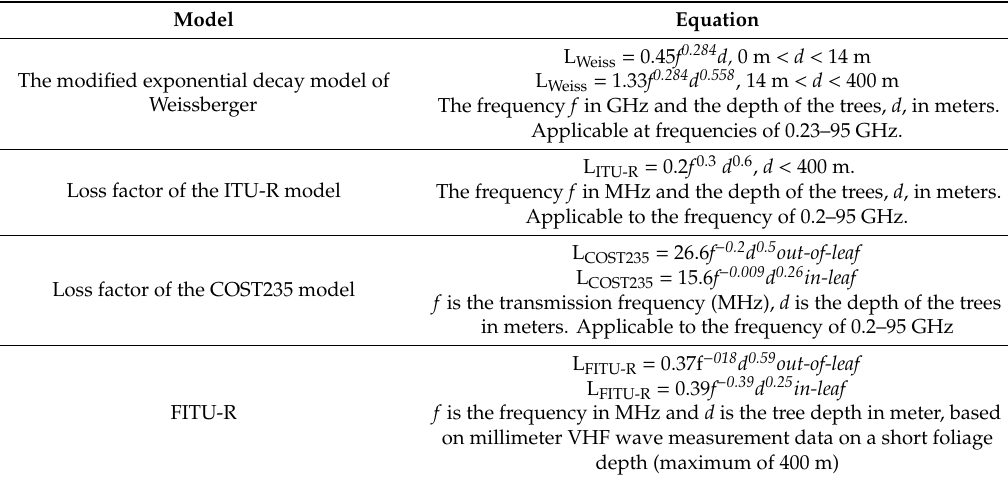
Table 1. Empirical propagation models.